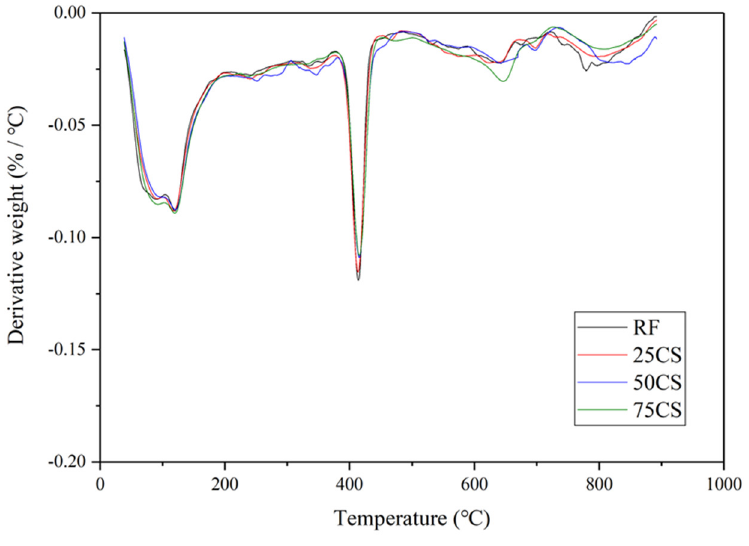
Figure 12. TGA results of CS specimens.3.2. Figures, Tables and